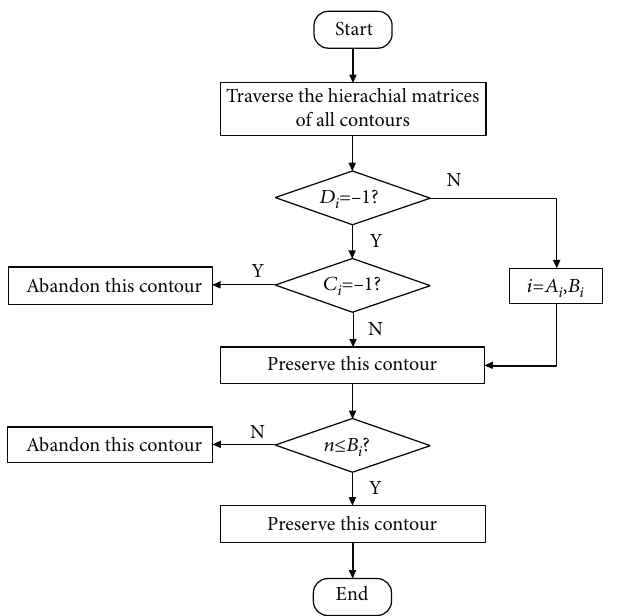
Figure 8: Flow chart of the contour selection algorithm of the main body.